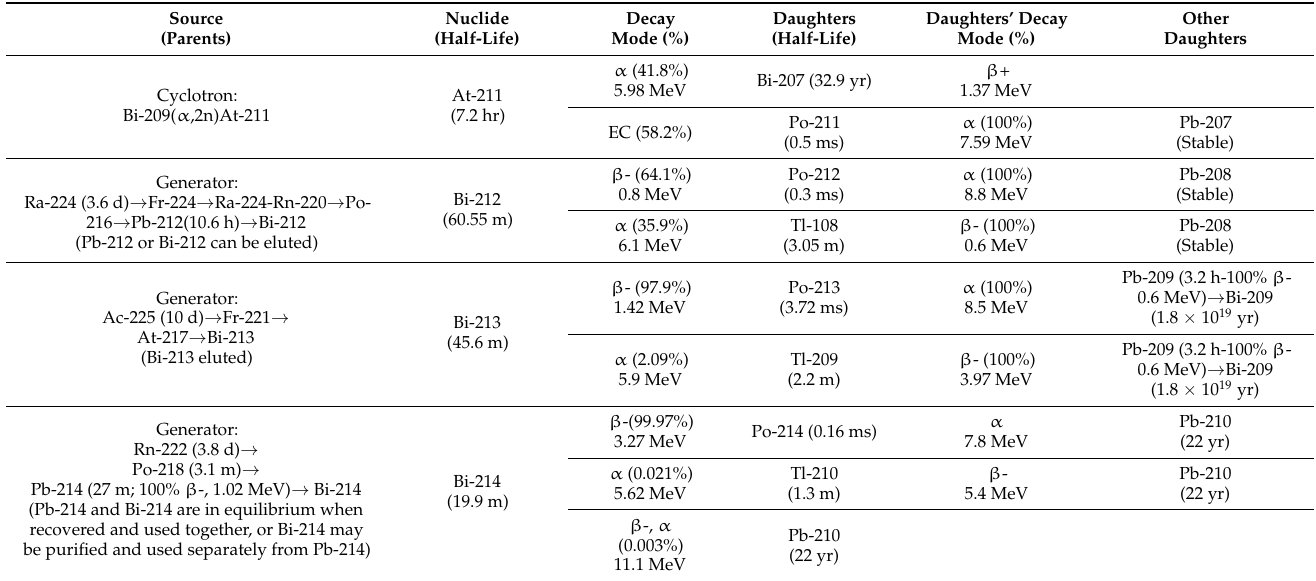
Table 5. Source and Decay Properties of Short-lived Radionuclides that Emit an α -Particle. https: //periodictable.com/Isotopes/085.211/index3.full.dm.html, accessed on 4 February